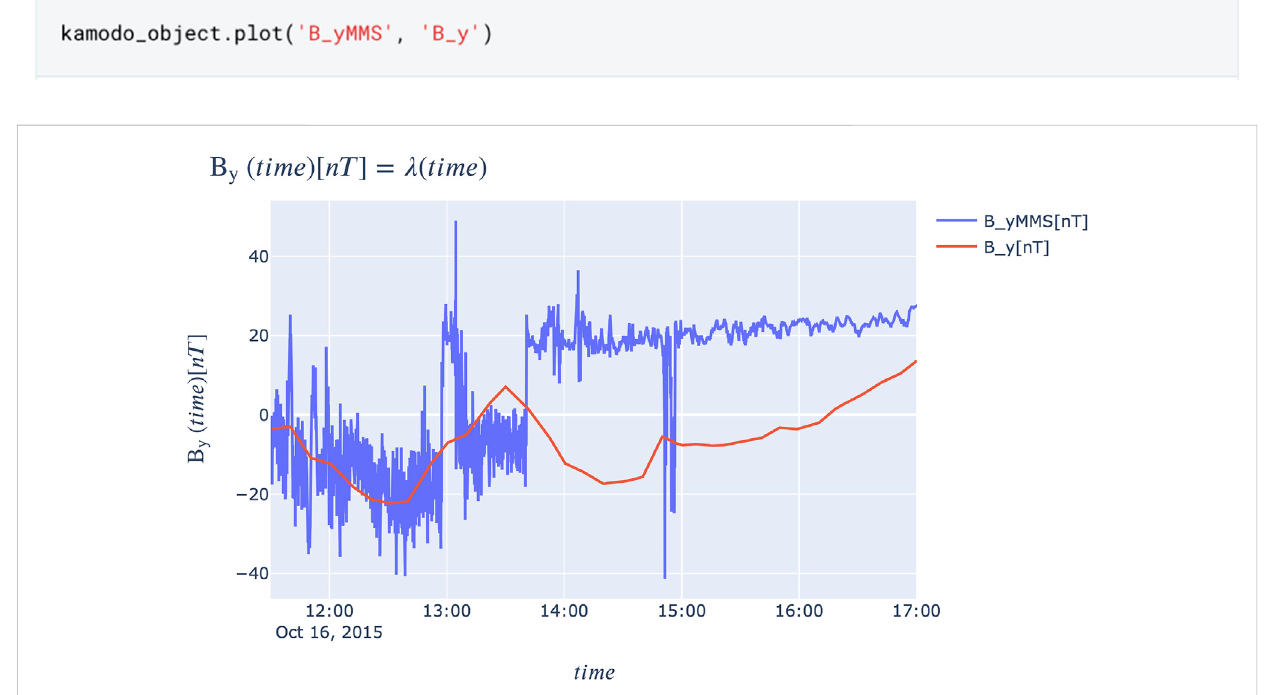
FIGURE 8 Time series plot of the observed B_y magnetic fi eld component (blue) with the modeled one (red).